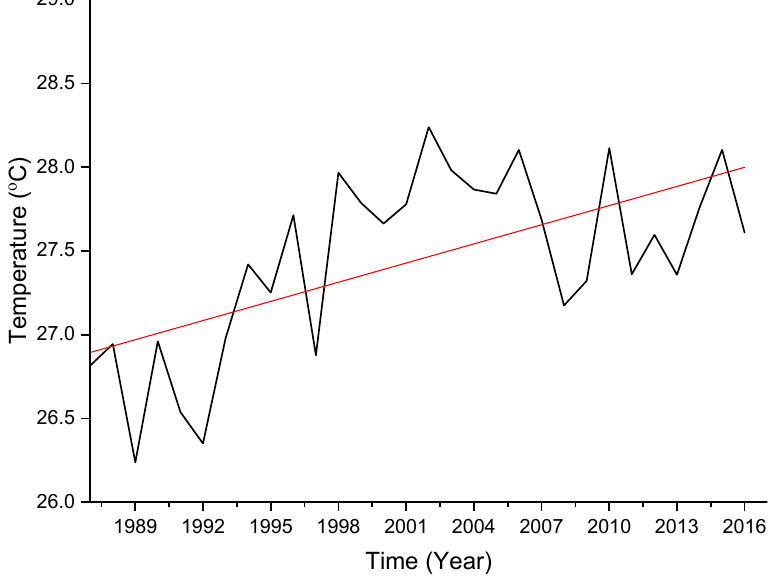
Figure 2. State-wide mean annual temperature in the state of Qatar from 1987–2016. Data source